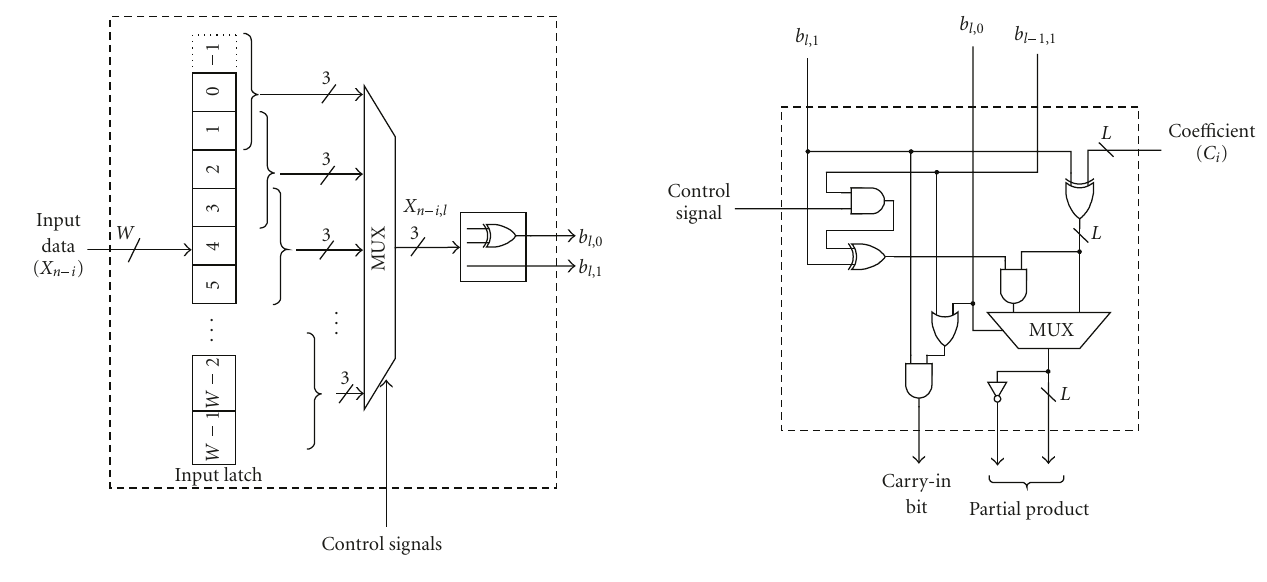
Figure 4: Preprocessing unit. Figure 5: Booth